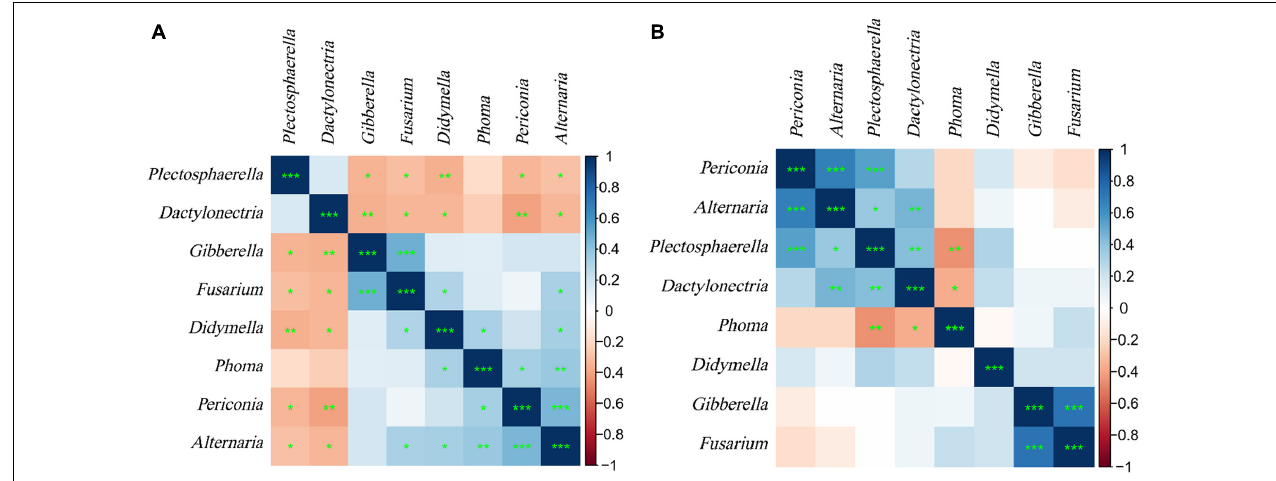
FIGURE 11 | Heat map of correlation coefficient of L. chuanxiong endophytic fungi. (A) Plant samples. (B) Soil samples. * is defined as significant, ** is defined as very significant, *** is defined as extremely significant. TABLE 1 | Soil physical and chemical factors in the rhizosphere of Ligusticum chuanxiong . Group pH Organicmatter (%) Hydrolyzed nitrogen (mg/kg) Available phosphorus (mg/kg) Available potassium (mg/kg)